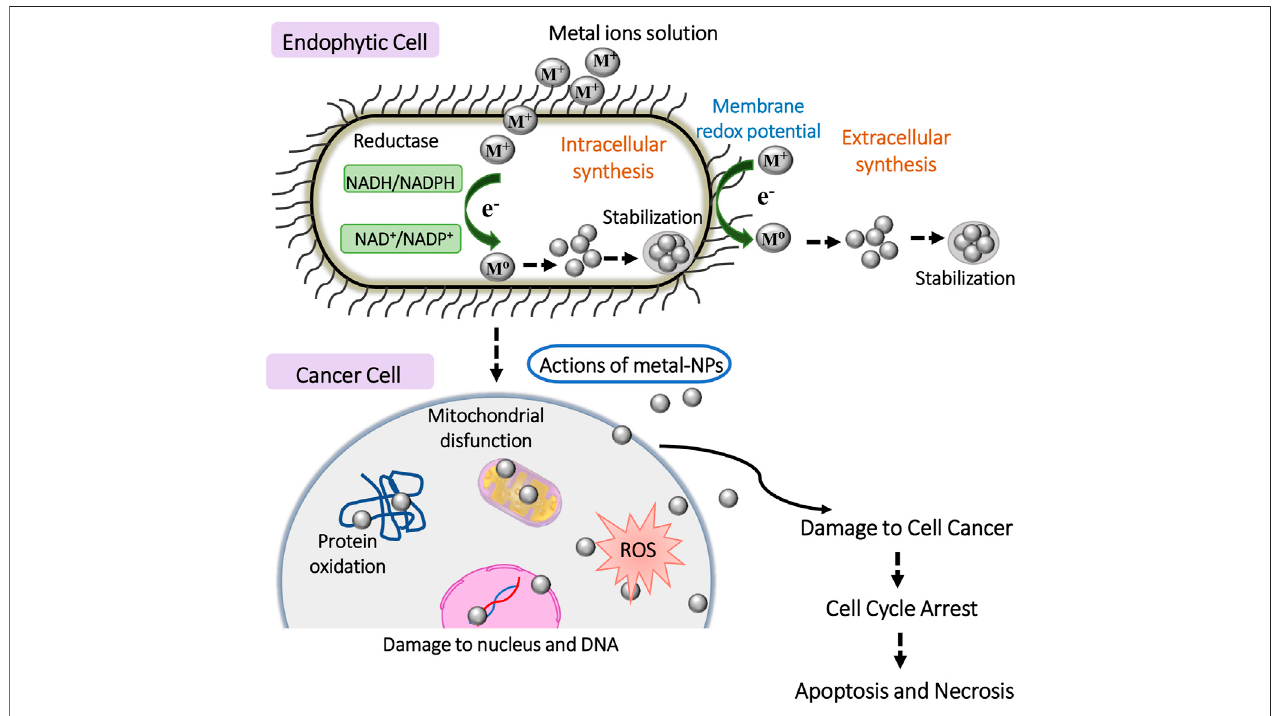
FIGURE 3 | Schematic representation of general anticancer mechanisms of metal-based NPs synthetized by intra-or extracellular mechanisms using endophytic cells. The interaction between the cancer cell surface and NPs and subsequent damage of organelles and biomolecules induces apoptosis and necrosis.